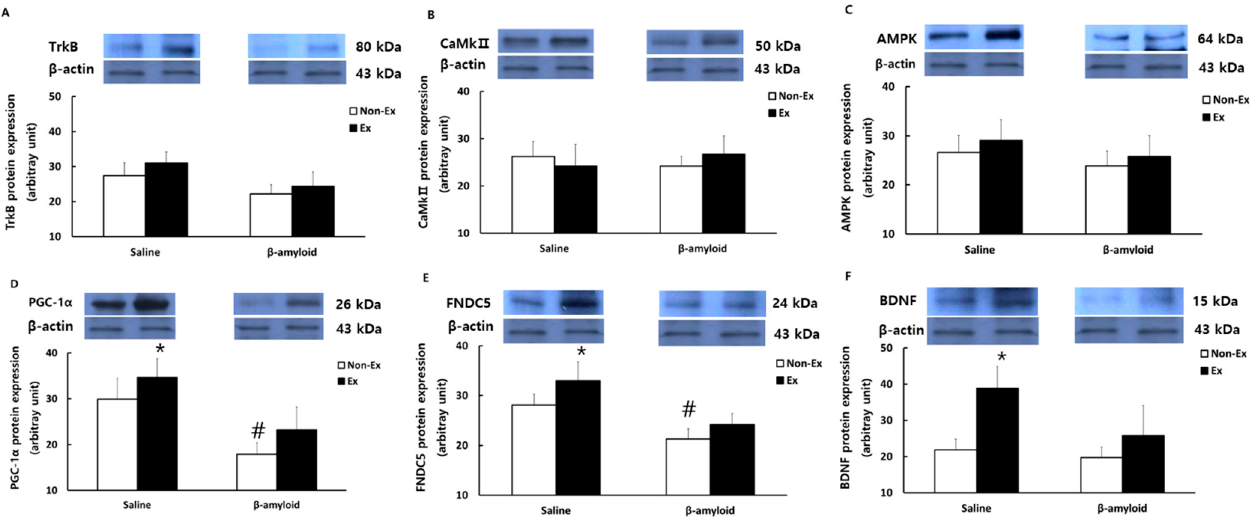
Figure 7. Comparisons of protein expressions of ( A ) TrkB, ( B ) CaMkII, ( C ) AMPK, ( D ) PGC-1 α , ( E ) FNDC5, and ( F ) BDNF in the quadriceps femoris after the 12-week intervention. (* p < 0.05 Significant difference as compared to Non-Ex group; # p < 0.05 Significant difference as compared to Saline group).